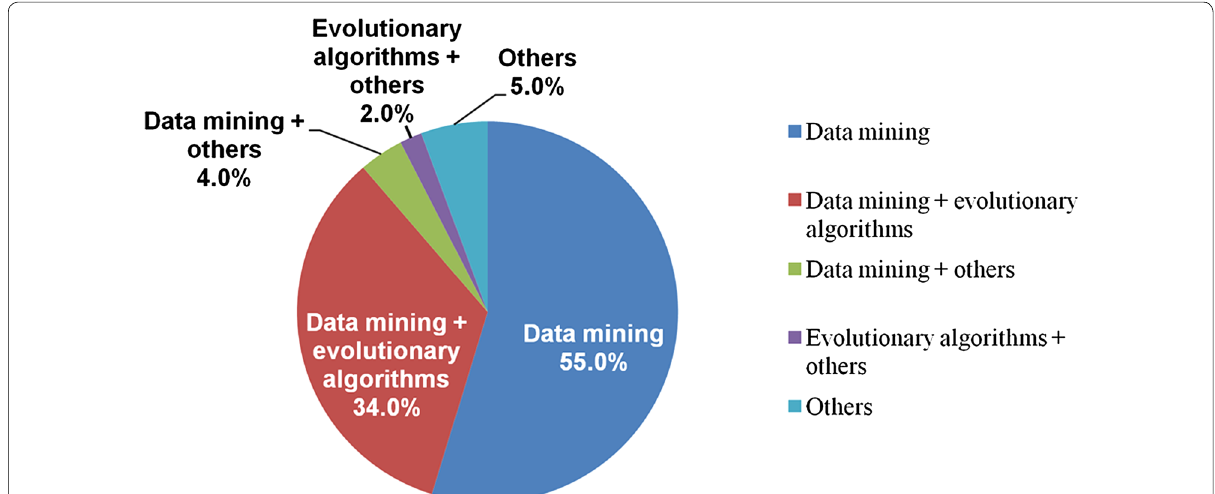
Fig. 7 Percentage of different methods used in lung cancer diagnosis. It shows the frequency of data mining methods and evolutionary algorithms used for lung cancer diagnosis, as reported in references